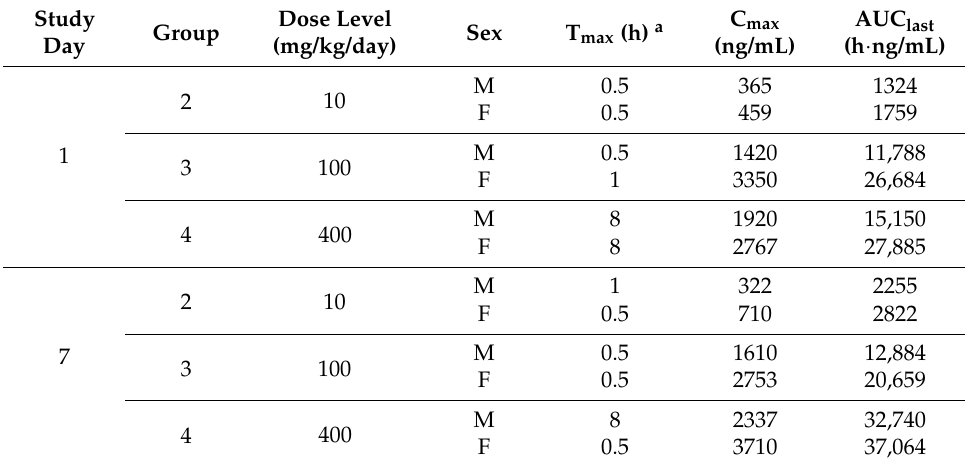
Figure 2. Pharmacokinetic profiles of ZB716 on day 1 ( A ) and day 7 ( B ) in Sprague Dawley rat plasma. Groups 2, 3, and 4 were given ZB716 at 10 mg/kg/day, 100 mg/kg/day, and 400 mg/kg/day, respectively. Table 2. ZB716 7-day repeated-dose PK parameters in rat plasma.